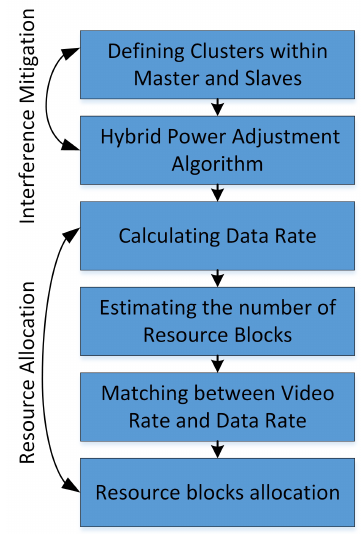
Figure 2. Flow diagram of the